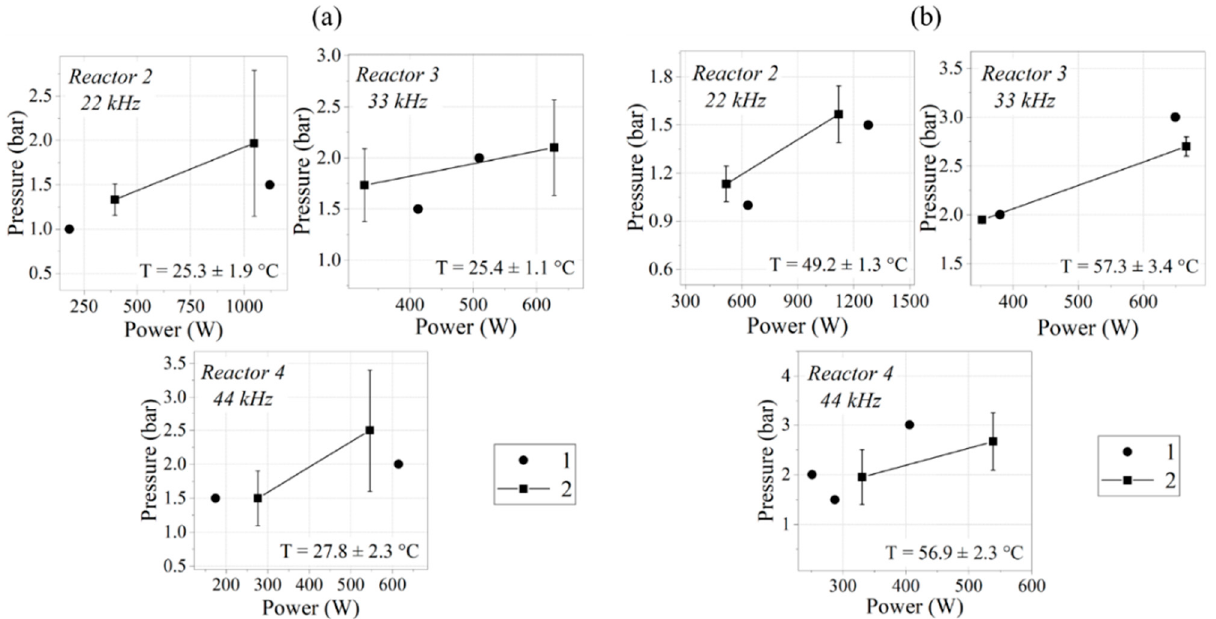
Figure 8. Comparison of the threshold transducer power that led to the cavitation onset obtained under two loading modes: 1—with a gradual increase in power at a constant external pressure (loading mode as shown in Figure 4a); 2—with a wave-like change in external pressure (loading mode as shown in Figure 4b). The tests were performed ( a ) at room temperature; ( b )at 50 °C.